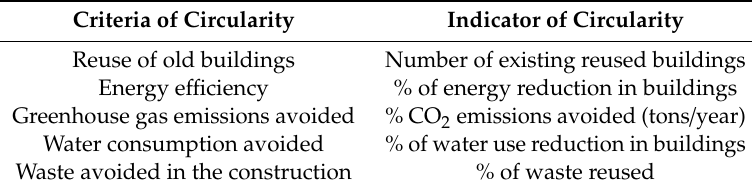
Table 1. Criteria and indicators of circularity in built environments